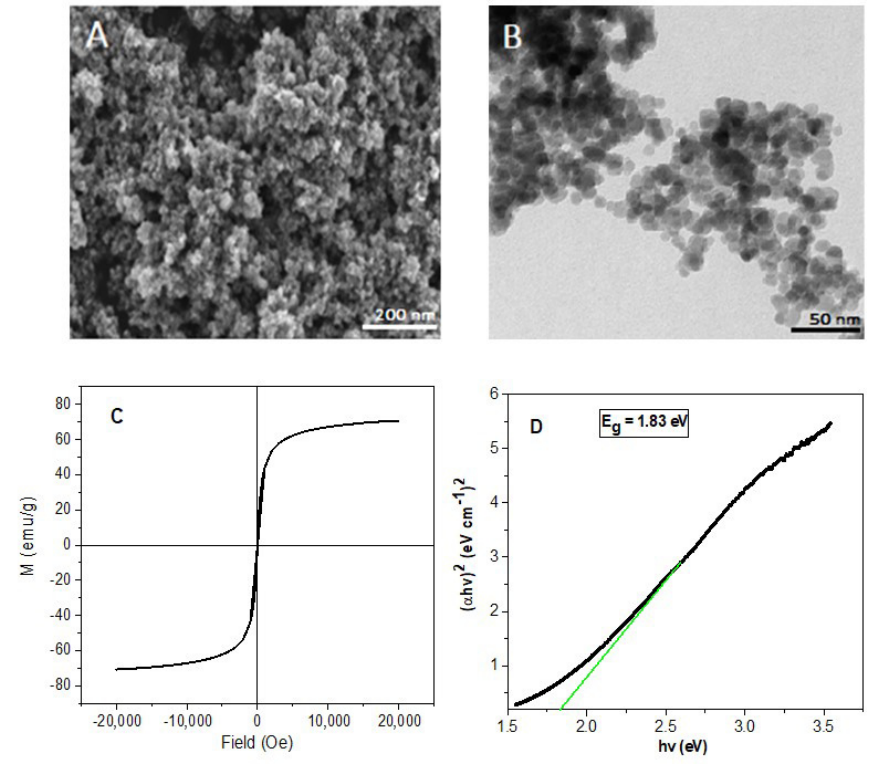
Figure 1. SEM ( A ) and TEM ( B ) images of maghemite nanoparticles, magnetization versus applied field ( C ), and the bandgap of maghemite nanoparticles ( D ).